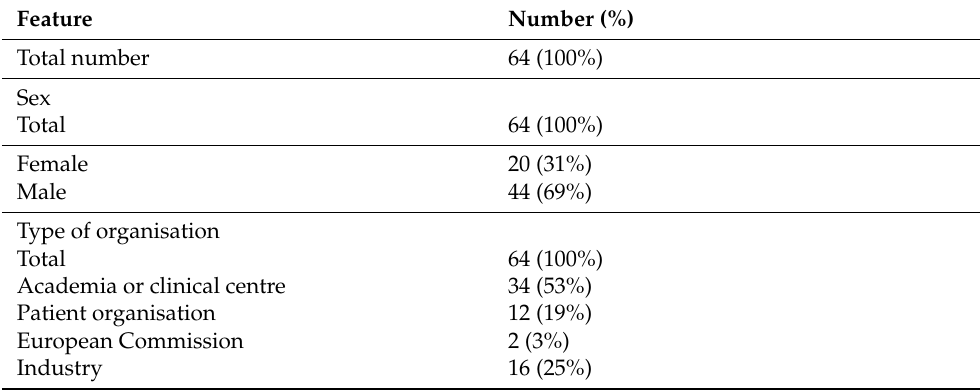
Table A2. Characterization of experts involved in the second round of expert